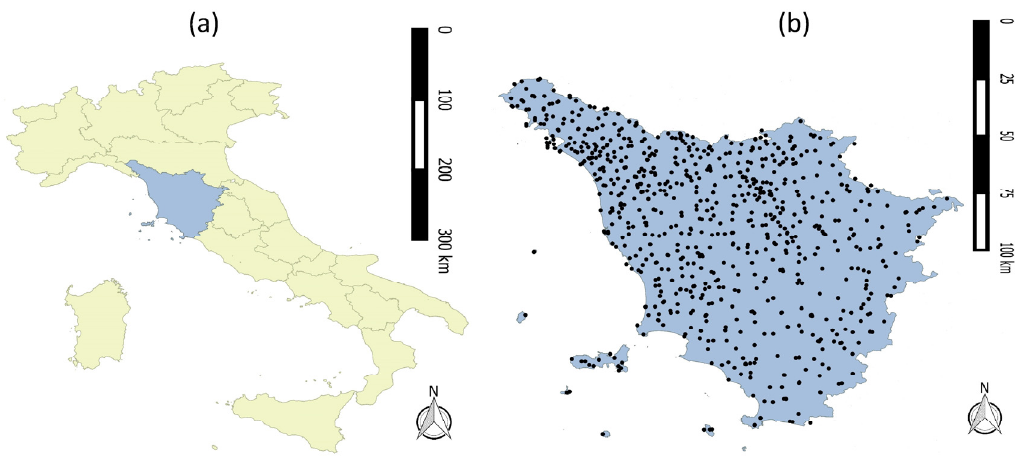
Figure 1. The Tuscany rain gauge network. ( a ) shows the position of the Tuscany region on the Italian peninsula; ( b ) the rain gauges installed in the region (March 2015).